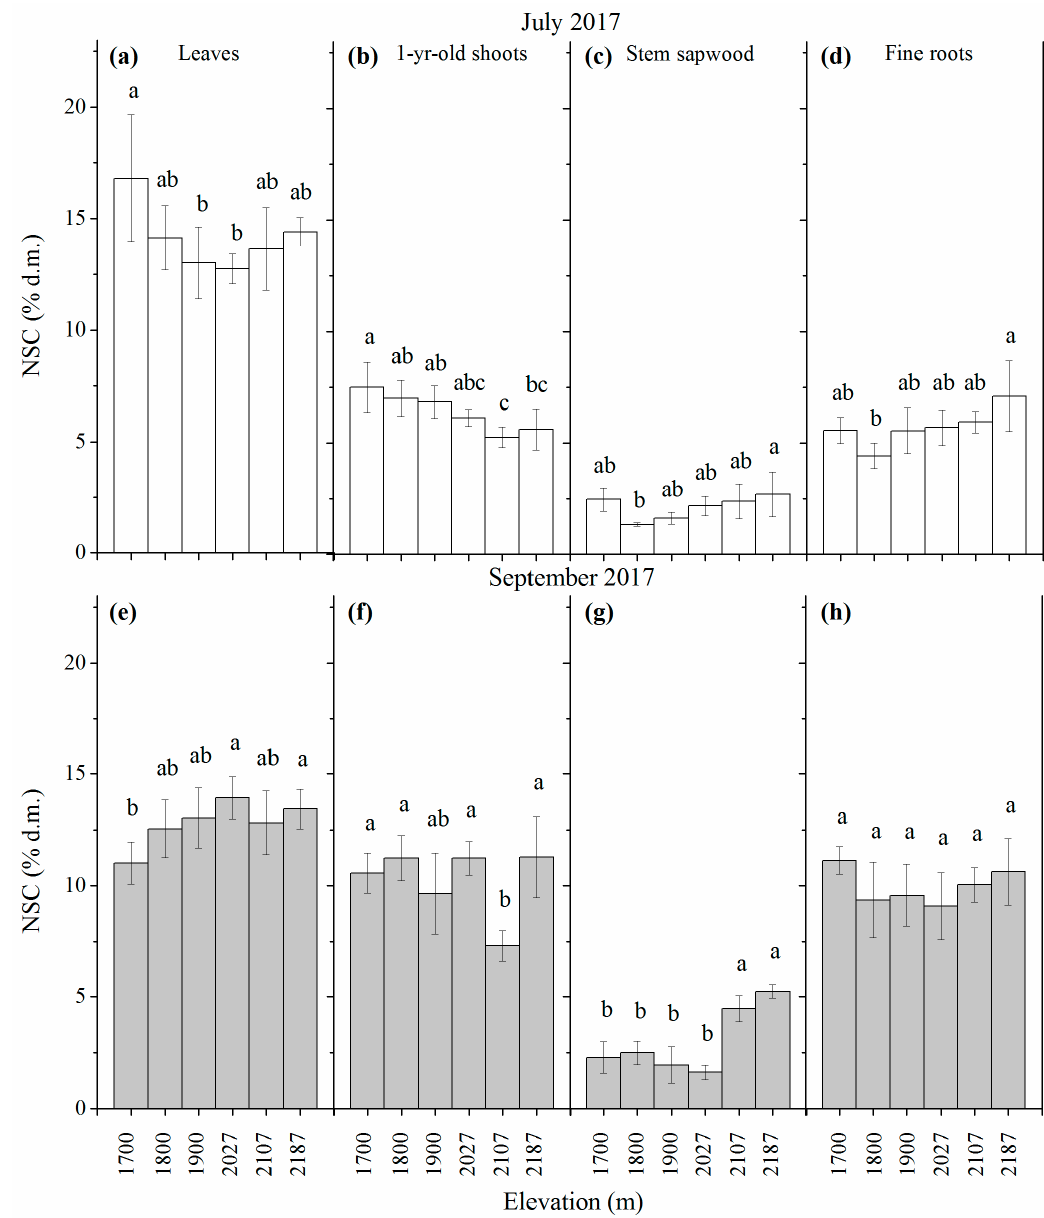
Figure 1. Seasonal tissues concentration (Mean ± 1SD; % of dry matter) changes in non-structural carbohydrate (NSC) compounds of Betula ermanii Cham. trees along elevational gradients in Changbai Mountain ( n = 5 for each elevational site and tissue type). Different letters display significant differences at the 0.05 level among elevations as determined by Tukey’s HSD test.